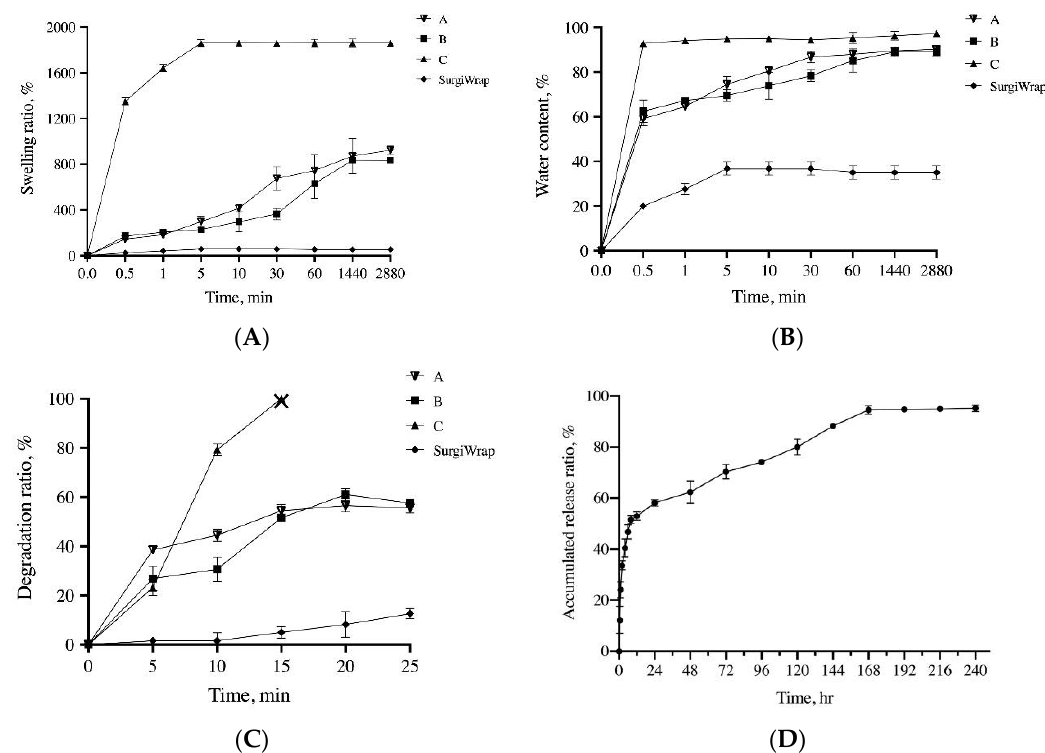
Figure 2. Basic properties of the GHF membranes; ( A ) water content; ( B ) swelling ratio, and ( C ) the degradation profiles of GHF and SurgiWrap membranes in PBS solution with a pH of 7.4 over 24 h; ( D ) the profile of the release of farnesol from the GHF membrane impregnated with 4 mM farnesol in PBS solution with a pH of 7.4 over a 10-day period. (Means ± S.D) A: membrane impregnated 0 mM farnesol, B: membrane impregnated 2 mM farnesol, and C: membrane impregnated 4 mM farnesol.